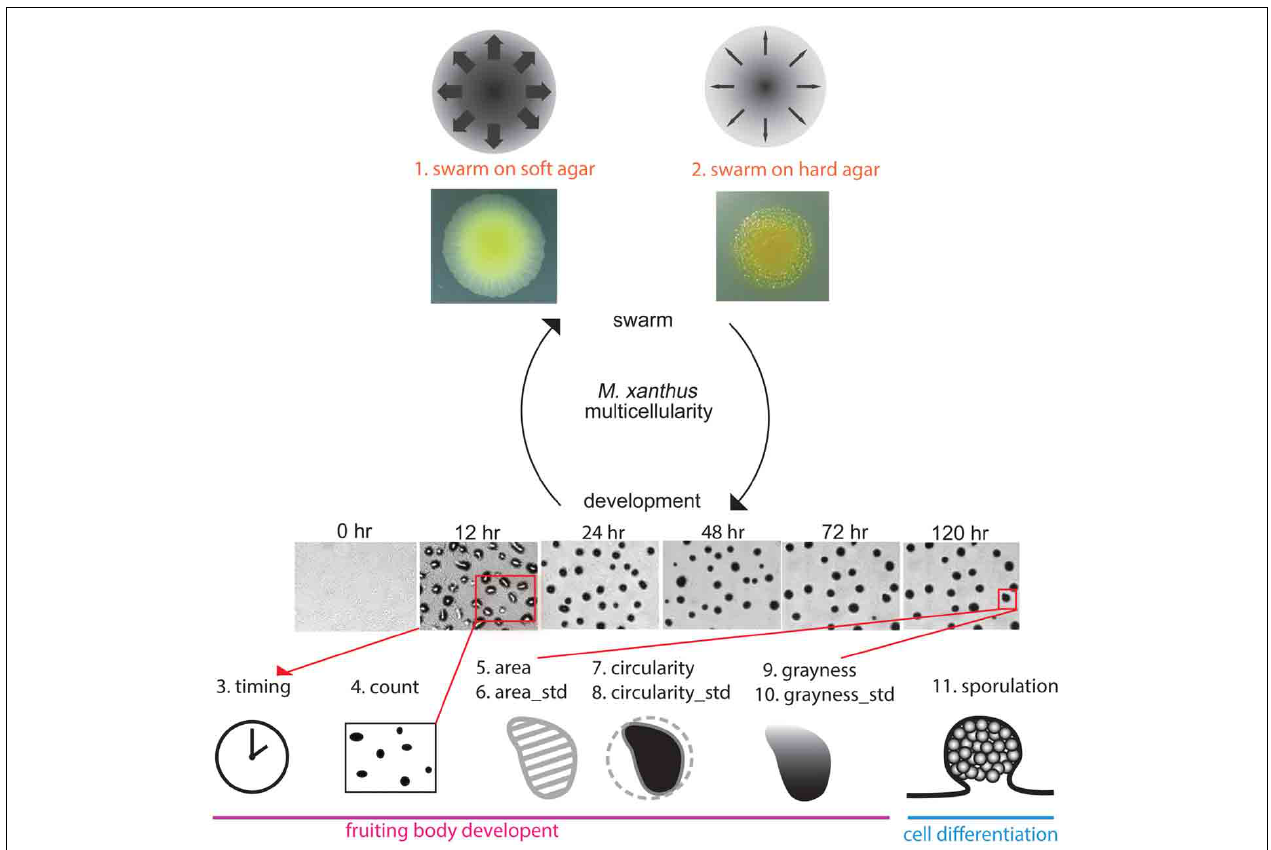
FIGURE 2 | Phenotypic traits and phenotypic assays. We tested eight phenotypic traits spanning the two parts of the M. xanthus life cycle: swarming (top) and development (bottom). Two data sets related to swarming were obtained under rich media using either soft (0.4%) or hard (1.5%) agar as rough measurements of S and A motility, respectively. Images of the two yellow colonies are swarms